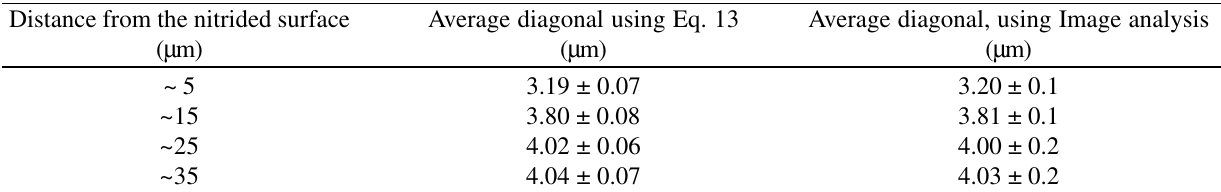
Table 4. Indentation diagonals beneath the surface in a nitrided specimen, determined by means of Eq. 13 and measured by image analysis. Maximum load: 50 mN.